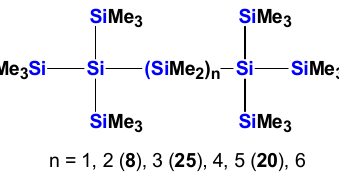
Figure 1. Oligosilanes with bulky tris(trimethylsilyl)silyl end groups.